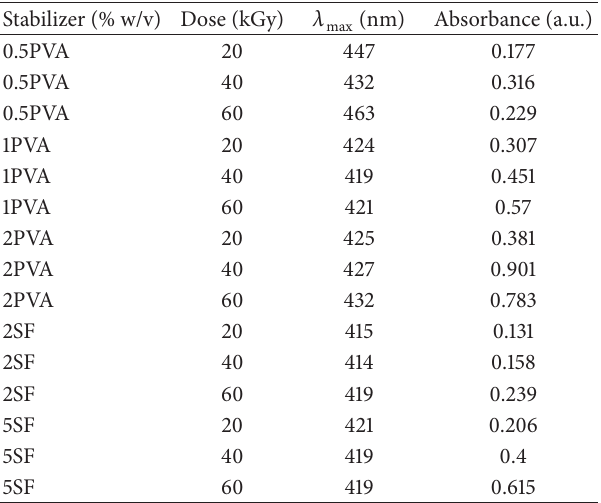
Table 1: Effect of irradiation dose and stabilizer concentration on the UV absorption of colloidal